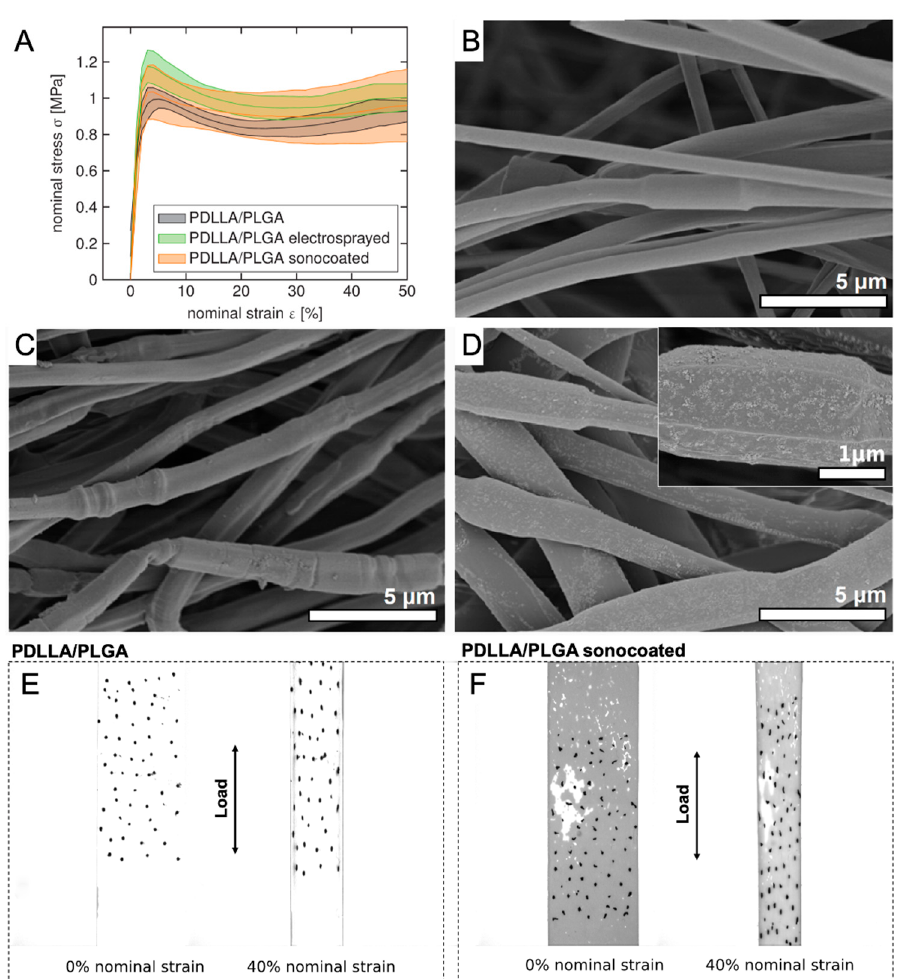
Figure 12. ( A ) Nominal strain-stress curve for coated and non-coated samples. All graphs show mean and standard deviation (shaded areas) from n = 3. SEM images of samples after tensile tests: ( B ) PDLLA / PLGA; ( C ) PDLLA / PLGA / nHA electrosprayed, and ( D ) PDLLA / PLGA / nHA sonocoated. Optical CCD camera images of ( E ) PDLLA / PLGA and ( F ) PDLLA / PLGA / nHA sonocoated during tensile properties testing in PBS.